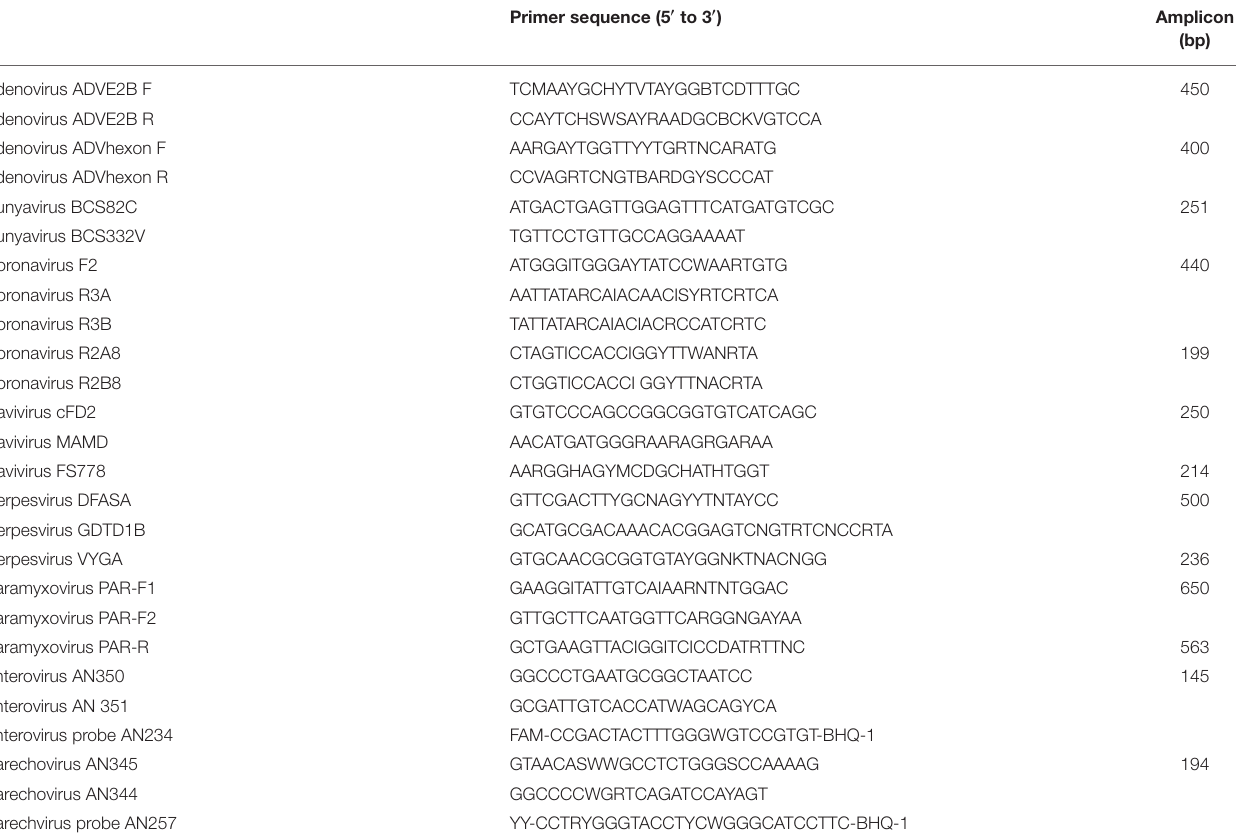
TABLE 1 | Sequences of viral oligonucleotide primers use for polymerase chain reaction.